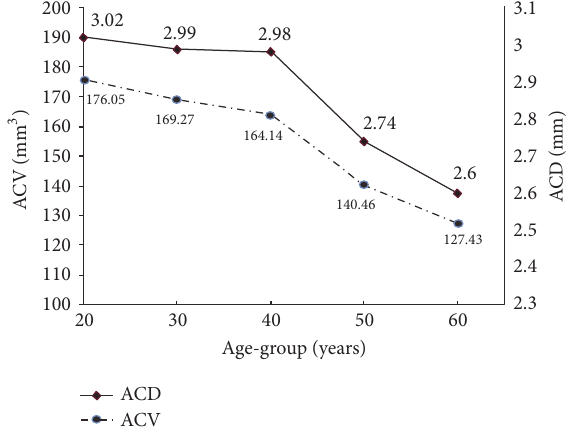
Figure 2: Relative reductions in anterior chamber volume (ACV) and depth (ACD) in different age-groups. Reducing rates in ACV and ACD were greatest in subjects aged 40–50